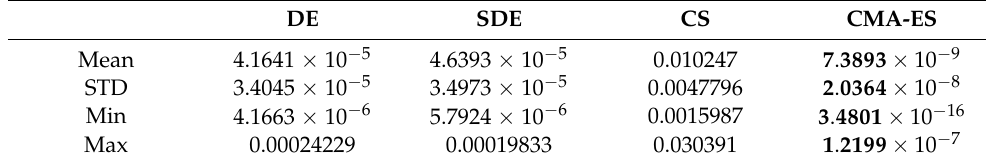
Table 10. Position error results for trapezoidal trajectory. The best results are highlighted in bold.